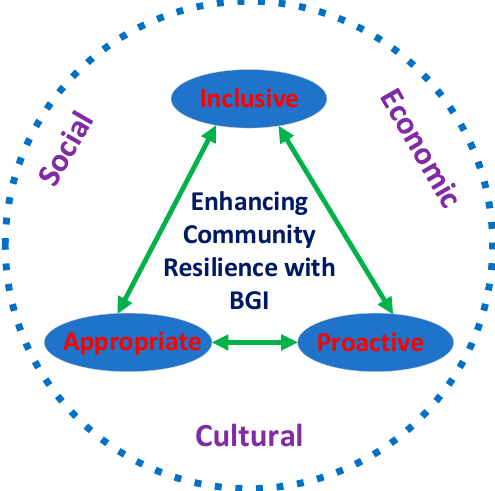
Figure 1. Representation of a community-centred approach to enhancing flood resilience with Blue–Green Infrastructure (BGI).